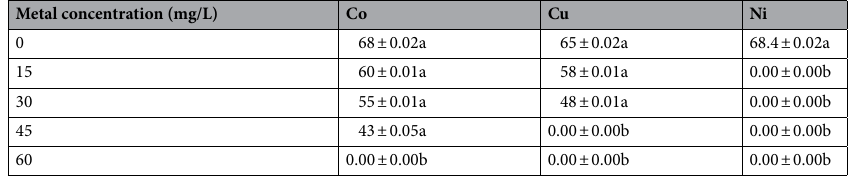
Table 3. Comparison of average dry weight (mg) of Pleurotus sp . mycelia grown in MMN liquid culture medium containing heavy metals based on Duncan’s test. Treatments with the same letters are not statistically